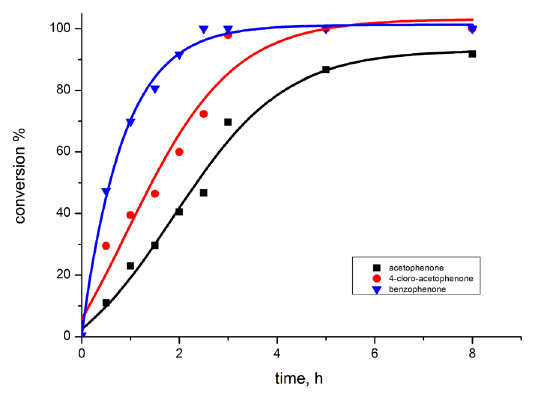
Figure 2: Time dependence of transfer hydrogenation of benzophenone, acetophenone and 4-chloroacetophenone by catalyst 1